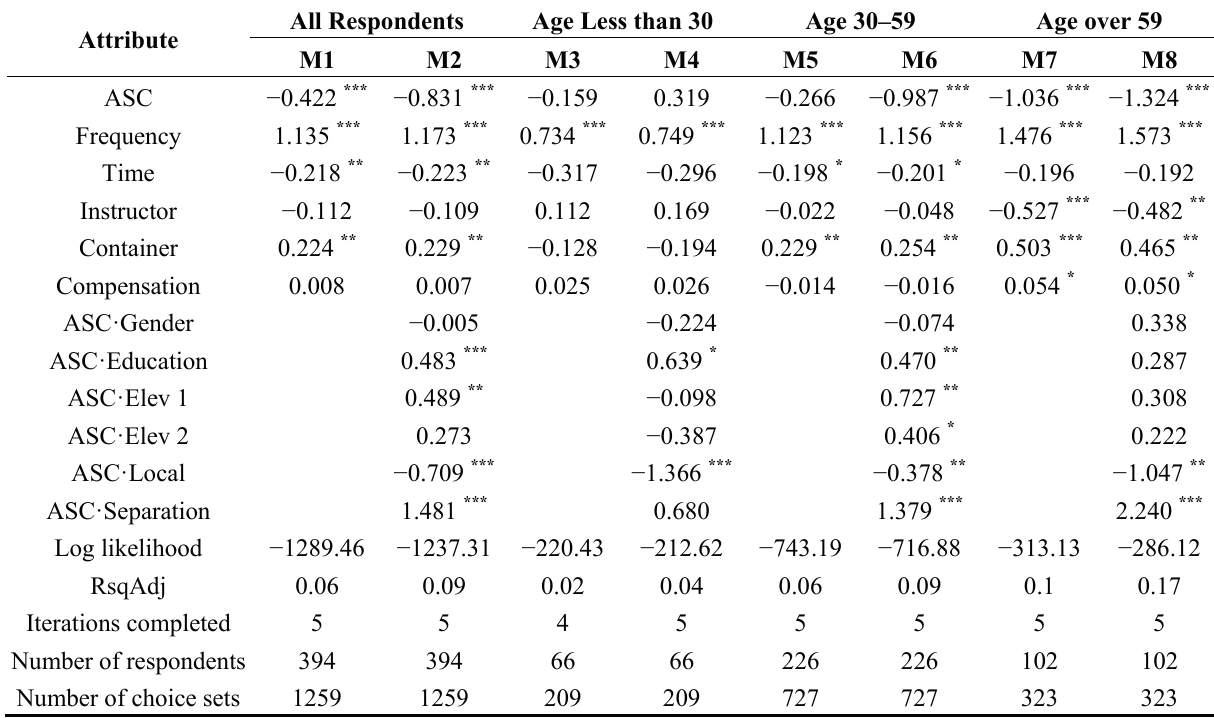
Table 4. Multinomial logit model estimates for all respondents, and respondents grouped by age